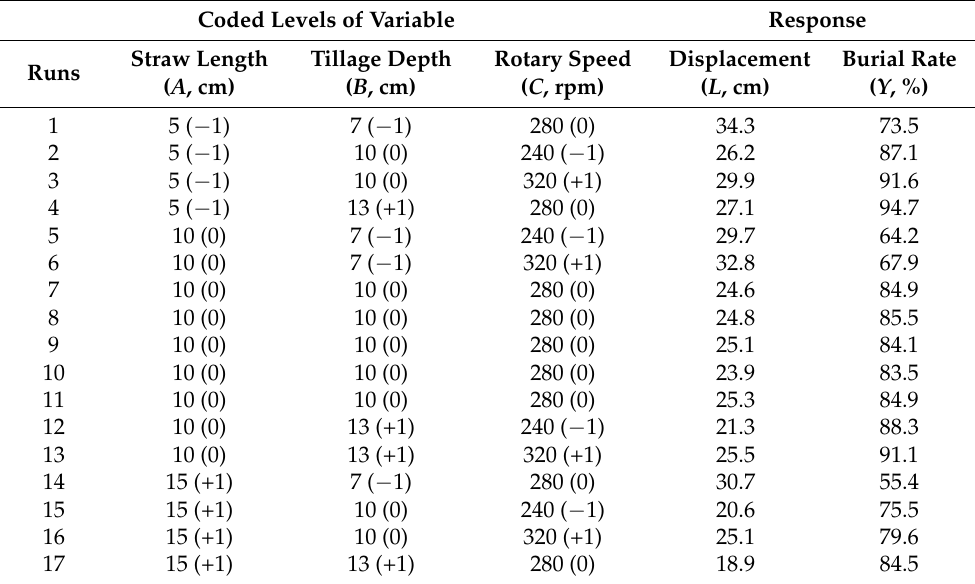
Table 3. Test design and